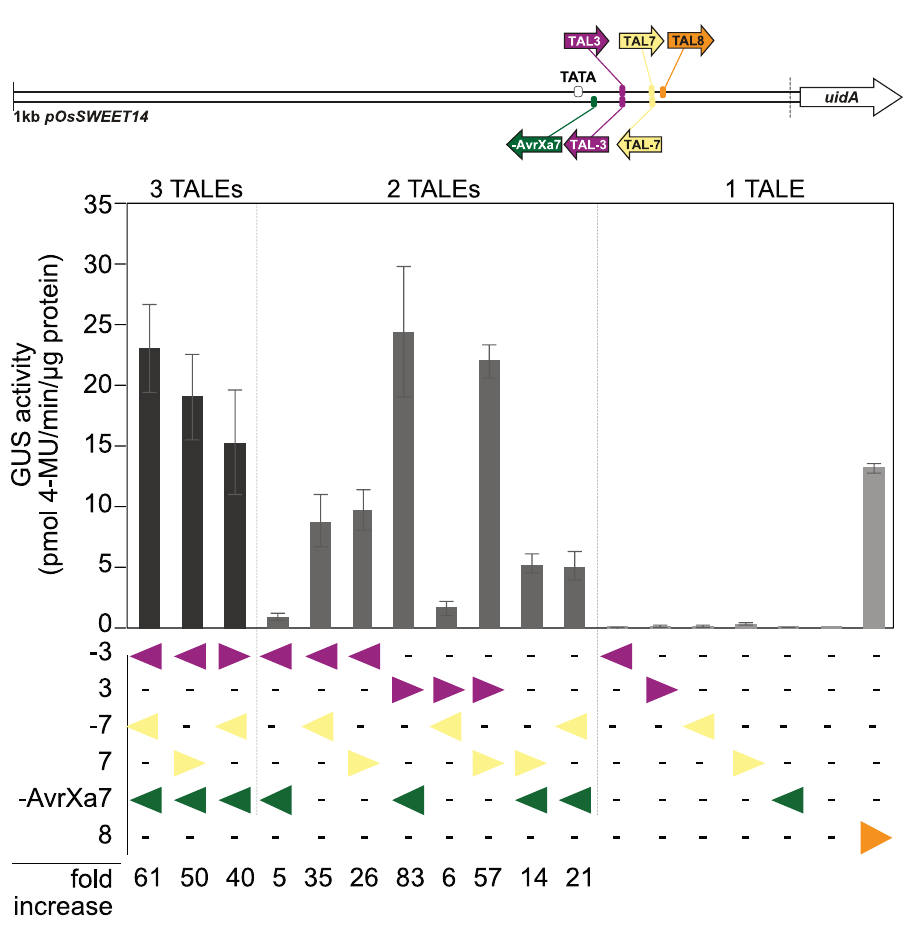
Fig 4. TALEs can synergize for gene induction. Agrobacterium strains deliveringTALE constructs and the OsSWEET14 :: uidA reporter, respectivelywere mixed at a ratio of 3:1 to a final OD of 1.6. If less than three different TALEs targeting the OsSWEET14 promoter were used, the remainderwas substituted with a Hax3 - deliveringstrain not targeting this reporter to keep the total ratio of TALEs constant. The highly active TAL8 was used as positive control. The bacterialmixture was inoculatedinto N . benthamiana leaves and GUS measurements were taken 2 dpi, error bars represent the standard deviationof three independentreplicates (4-MU, 4-methyl-umbelliferone). Pleasenote that the GUS values of individuallow-activeTALEs was consistently very low here in comparisonto Fig 3, probablydue to the higherdilutionfactor of the reporter construct in this experimental